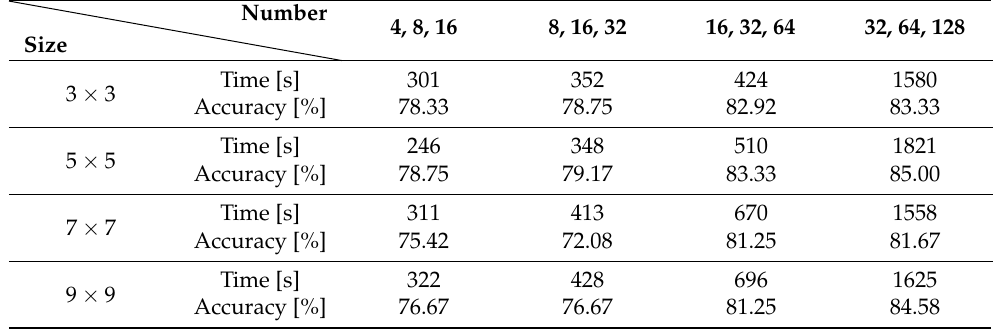
Table 6. Elapsed time and validation accuracy for CNN training by different size and number of kernels.